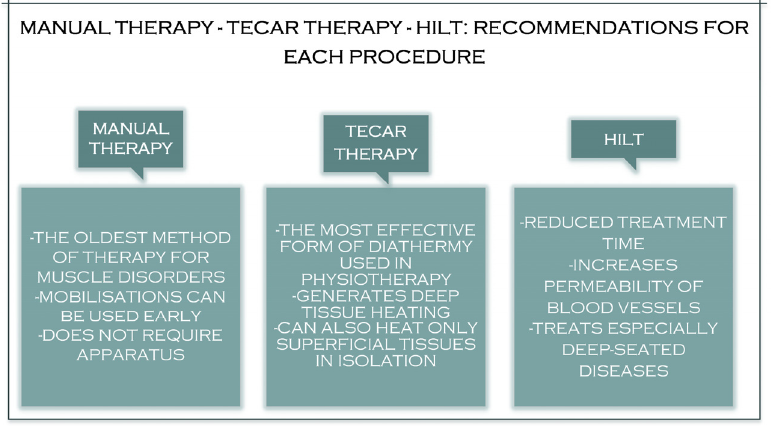
Figure 6. The advantages of recommending manual therapy, TECAR, and HILT therapy.